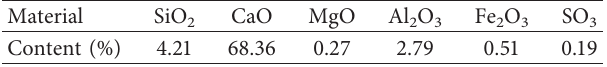
Table 2: Chemical composition of calcium carbide slag.